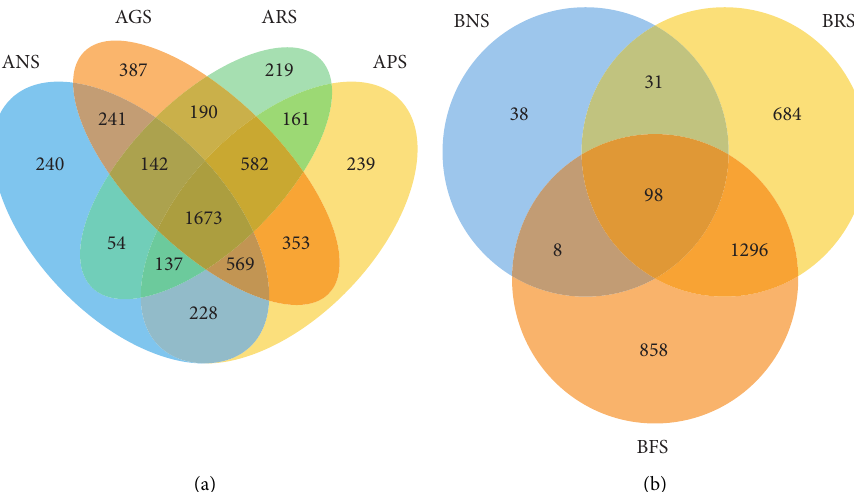
Figure 3: Venn diagram of exclusive and shared bacterial in growth substrate of moss samples (at the OTUs level). (a) Venn diagram analyzed composition similarities and differences of bacteria in growth substrate of mosses (AGS, ARS, and APS) and bare soil (ANS) samples collected from mine waste slag areas. (b) Venn diagram analyzed composition similarities and differences of bacteria in growth substrate of mosses (BRS, BFS) and bare soil (BNS) samples collected from electrolytic manganese slag areas.